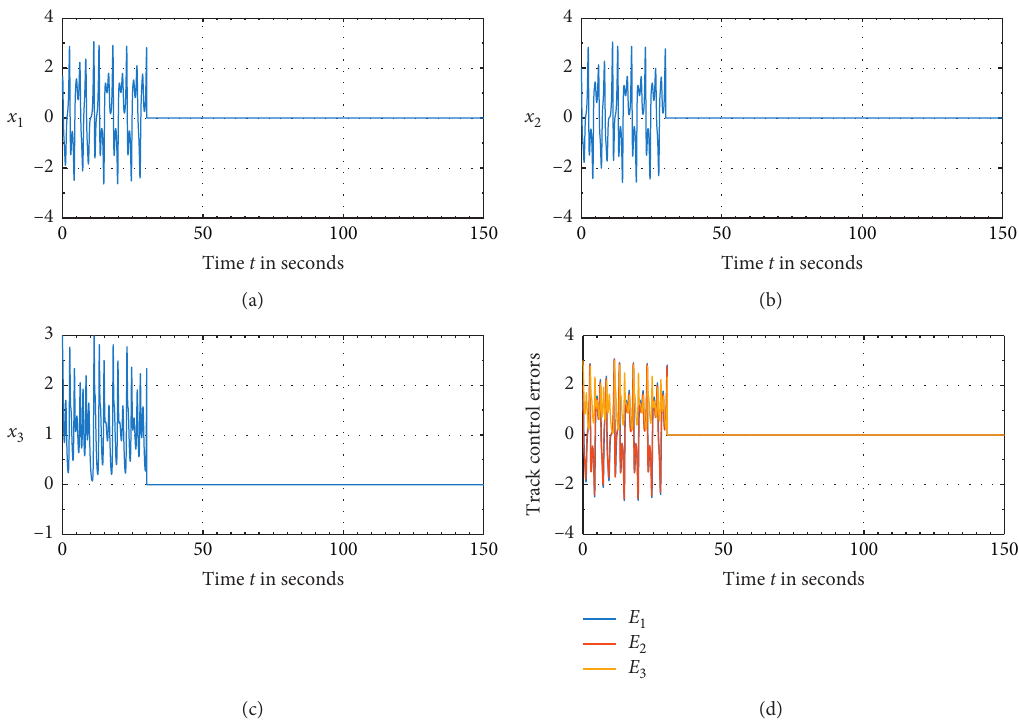
Figure 9: State dynamics under the track control method with reference ( 0 , 0 , 0 ) and the controller gain k � − 8, where the controller is applied after 30secs. (a) The state variable x